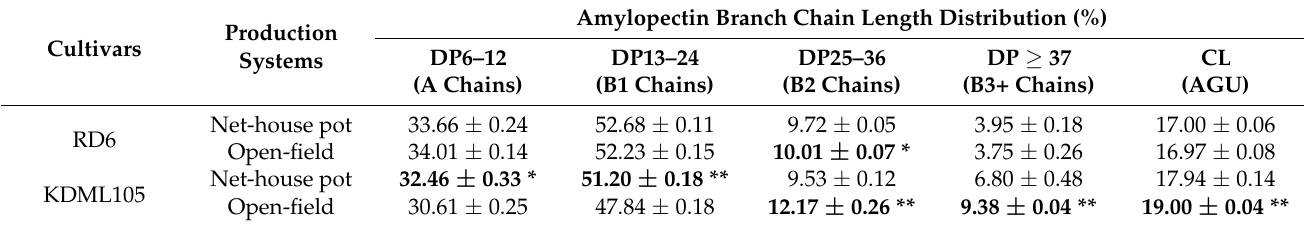
Table 5. Chain-length distributions and average chain length of amylopectin branches of grain starch of the two elite Thai rice cultivars grown in the net-house pot and open-field production systems.